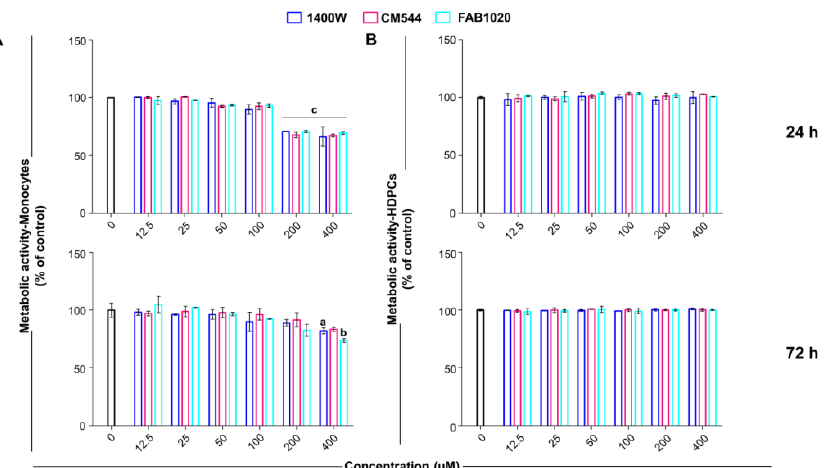
Figure 2. Cell metabolic activity of human monocytes and HDPCs (MTS assay). Cell cultures were exposed to 1400 W, CM544 or FAB1020 for 24 or 72 h. Bars represent the percentages of cell metabolic activity in the presence of compounds (0–400 µ M) in human monocytes ( A ) or HPDCs ( B ). OD values in control untreated cultures (0 µ M, black bars) are set to 100%. a = p < 0.01, b = p < 0.001 and c = p < 0.0001 between treated cells and the untreated control.